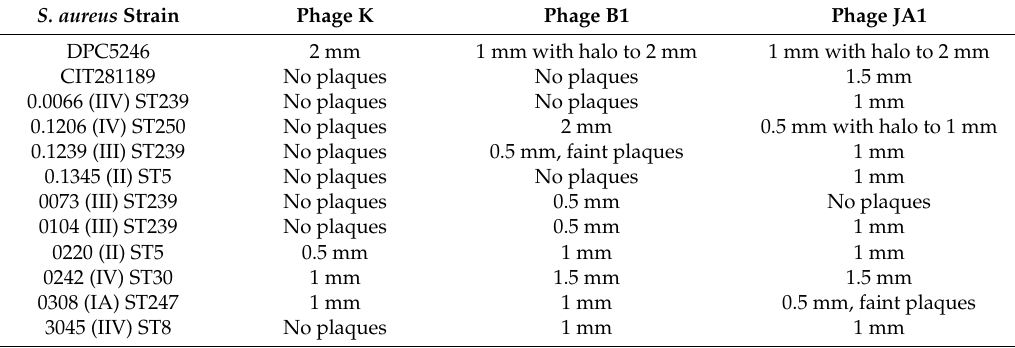
Table 3. Zone sizes and morphologies of B1, JA1, and K plaques formed on MRSA strains collected from the Irish National MRSA Reference Laboratory (St. James’s Hospital Dublin,